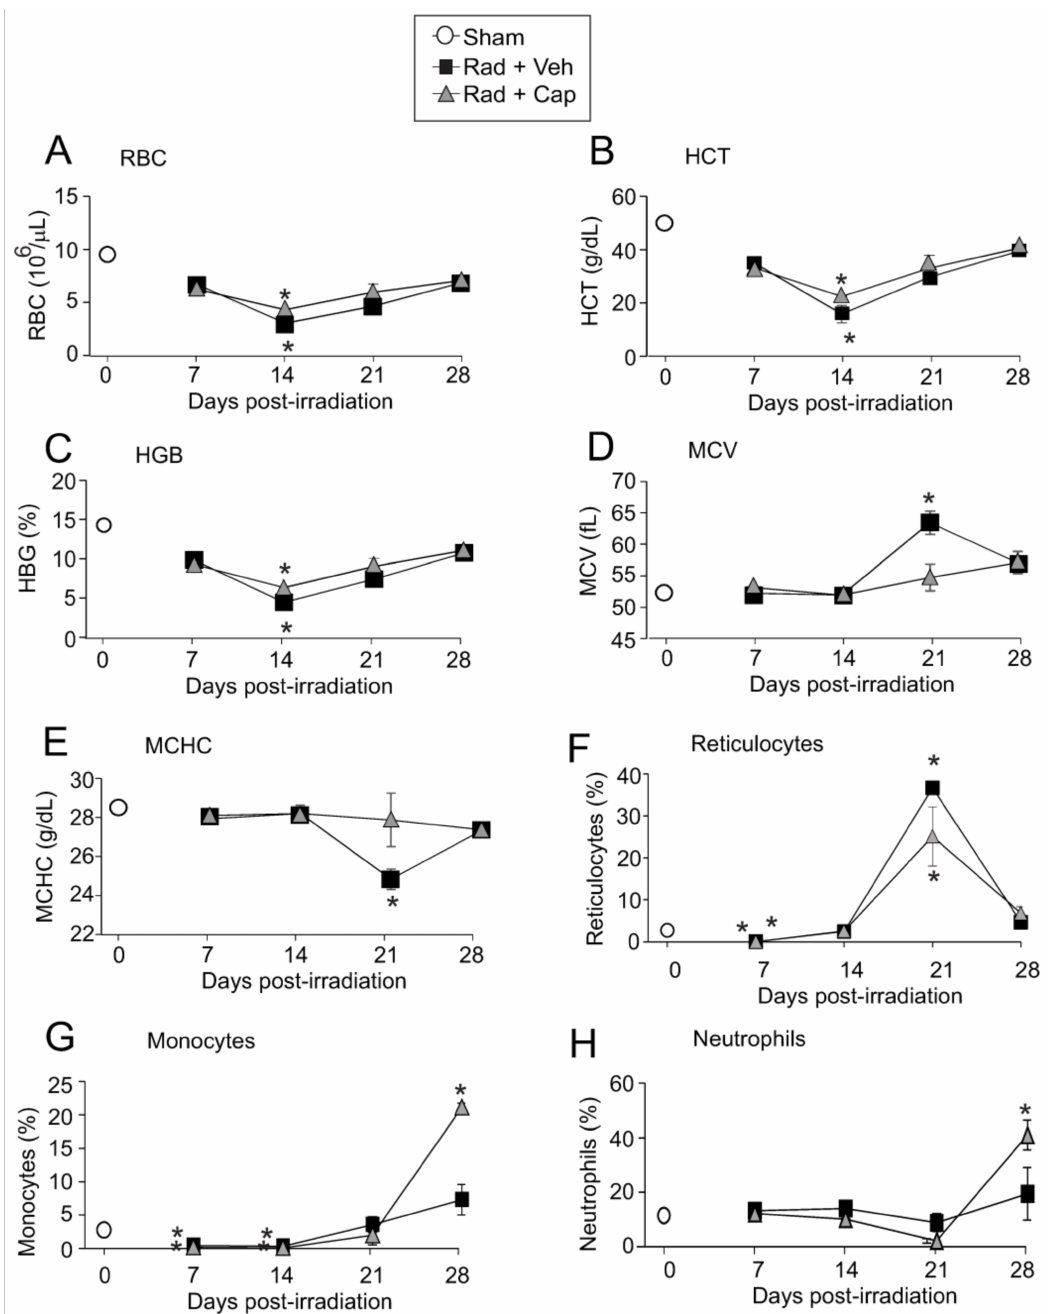
Figure 1. Total body irradiation causes decreased red blood cell, hematocrit, and hemoglobin levels. C57BL/6 mice were exposed to 6.85 Gy total body irradiation. Animals received vehicle (drinking water alone) or captopril in the drinking water from days +2–+16 post-irradiation. At the indicated time points, mice were euthanized, and blood was obtained for complete blood cell counts. Control (Sham) blood cell levels are indicated by an open circle at day 0. ( A ) red blood cells (RBC); ( B ) hematocrit (HCT); ( C ) hemoglobin (HGB); ( D ) mean corpuscular volume (MCV); ( E ) mean corpuscular hematocrit (MCHC); ( F ) reticulocytes; ( G ) monocytes; and ( H ) neutrophils. Data show means ± SEM, from n = 3 animals per group; * indicates p < 0.05 from control (sham irradiated)